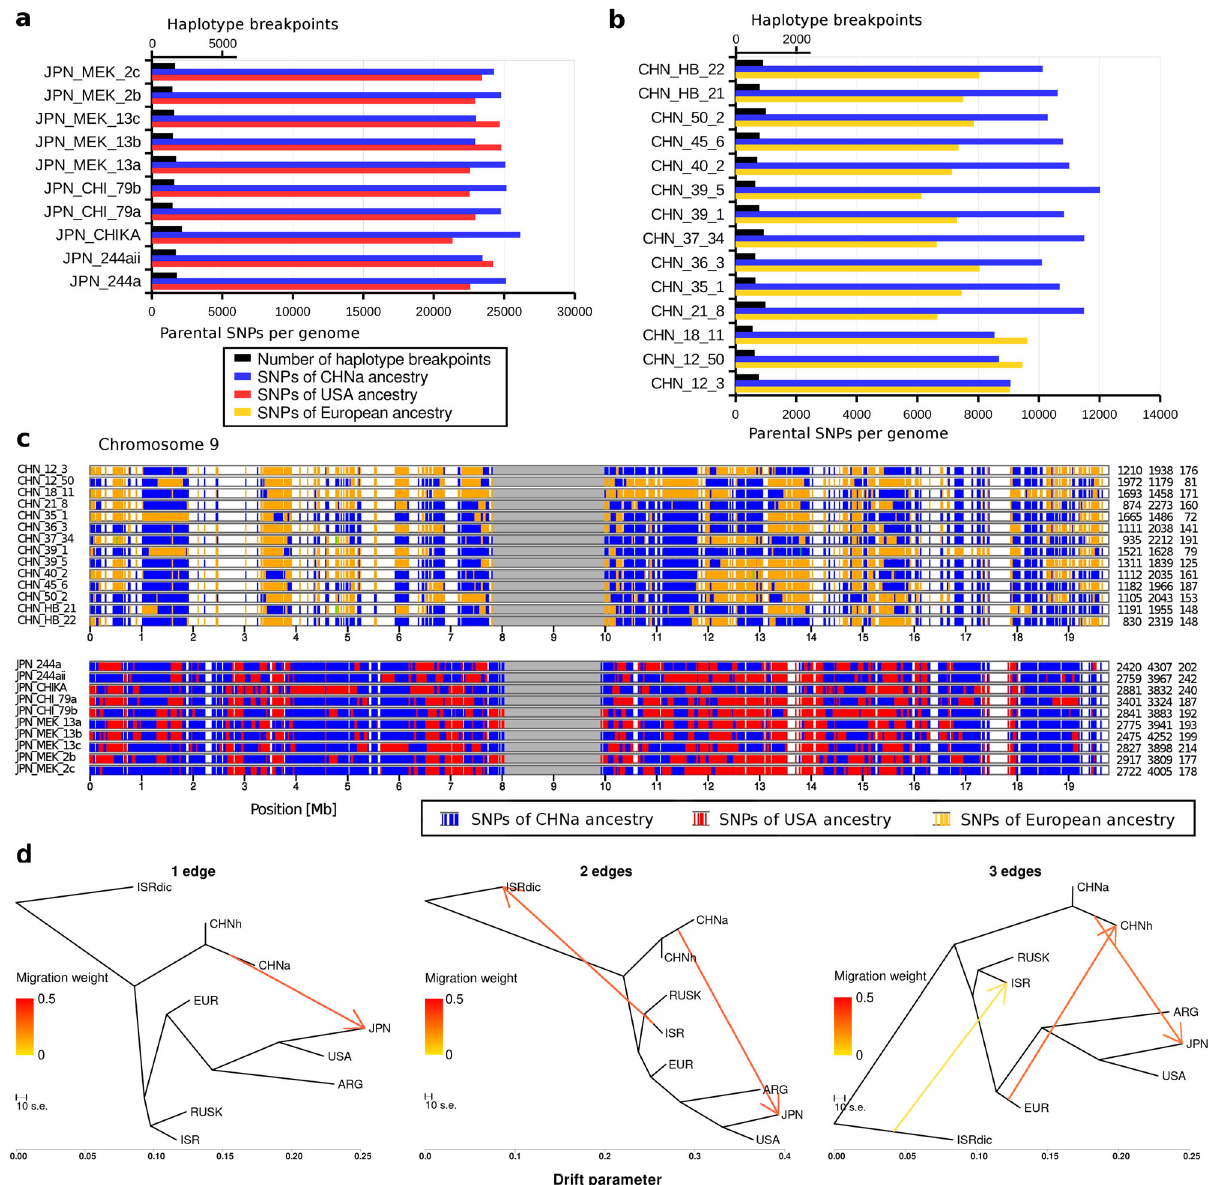
Fig. 4 Genomic composition of young hybrid populations from Japan and China. a Numbers of nucleotide variants and breakpoints between haploblocks (i.e., blocks of multiple consecutive SNPs inherited from a single parent), in putative hybrid populations from Japan. Mildew isolates from Japan seem to be hybrids between mildews from the USA and from China. In black are the numbers of breakpoints between chromosomal segments that come from either of the parents. In red and blue are the counts of identi fi ed nucleotide variants that could be assigned to either of the parents. b Analogous to ( a ). Mildews of the CHNh sub-population are likely hybrids between ancestral Chinese and European mildews. c Examples for the genomic mosaics that is caused by segments that come from different parental populations. Nucleotide variants are indicated by vertical bars. Colors identify the parental populations. d TreeMix analysis for one to three edges using B.g. dicocci as an outgroup. The red arrow indicates the migration event while the redness indicates its weight which approximates 50%. ISRdic refers to the B.g. dicocci